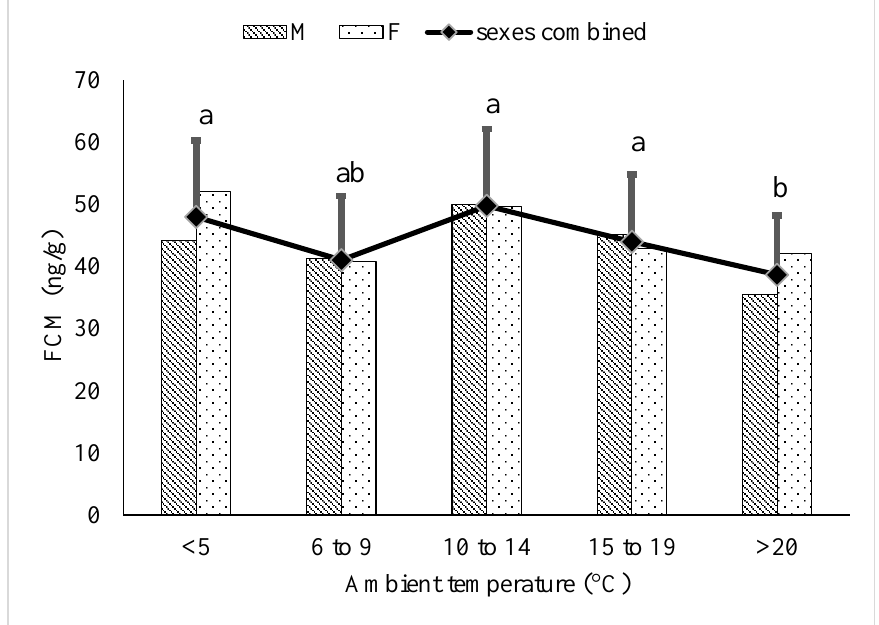
Figure 2. Back-transformed LSMeans ± SEM for fecal cortisol metabolite (FCM) concentrations (ng/g dry feces) within different ambient temperature categories for elderly (≥18 years) polar bears (N samples = 3011). Different subscripts represent differences between temperature categories ( p < 0.05). Columns represent sex-specific back-transformed LSMeans for each temperature category.